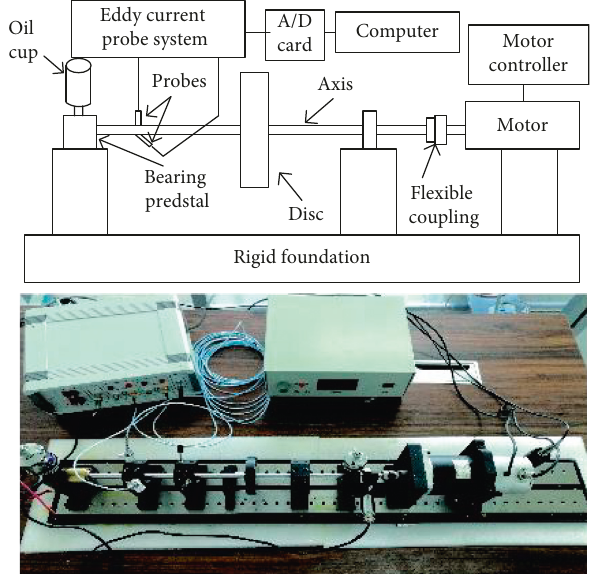
Figure 3: The schematic diagram and the experimental apparatus.